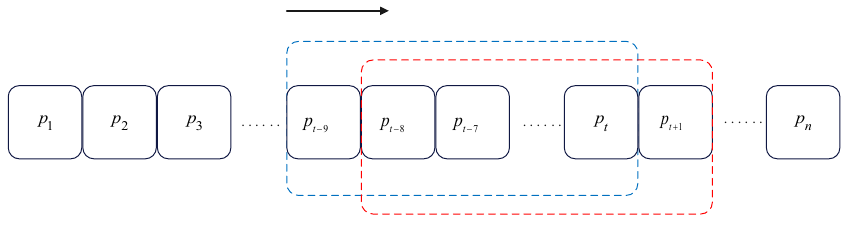
Figure 13. Sliding time window.